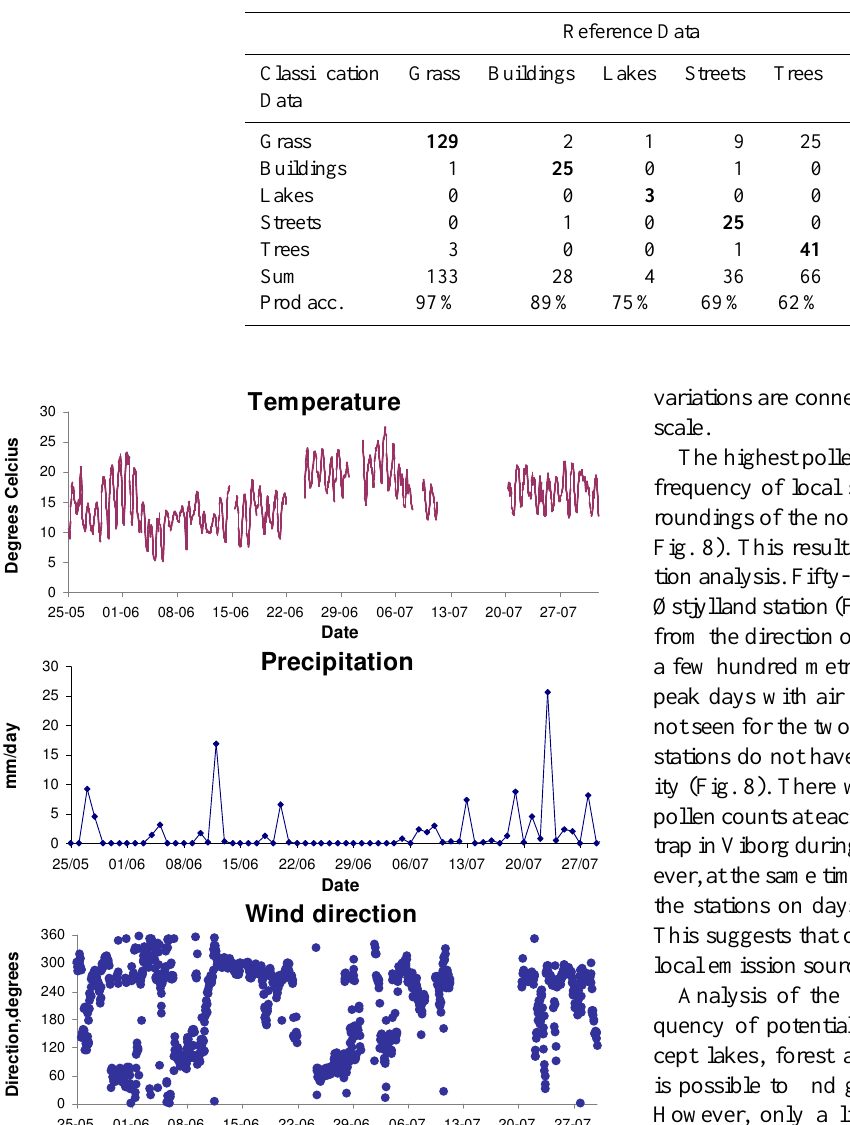
Table 2. Error matrix associated with the NDVI analysis (Fig. 3) of the Quickbird images covering the Aarhus area. User accuracy (User acc.) and Producer accuracy (Prod acc.) are based on standard methodologies according to Lillesand and Kiefer (2007).